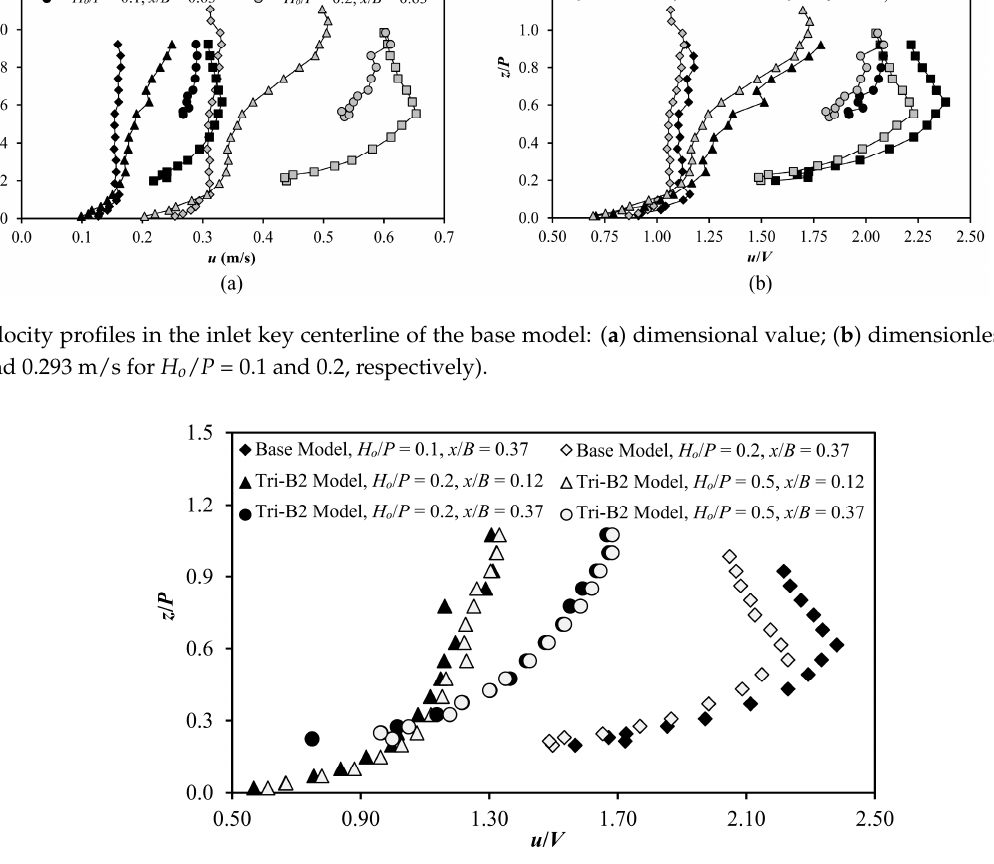
Figure 8. Dimensionless velocity profiles in inlet key centerlines ( V = 0.140, 0.293, 0.197, and 0.454 m/s at the base model with H o / P = 0.1 and 0.2 and the Tri-B2 model with H o / P = 0.2 and 0.5, respec- tively).